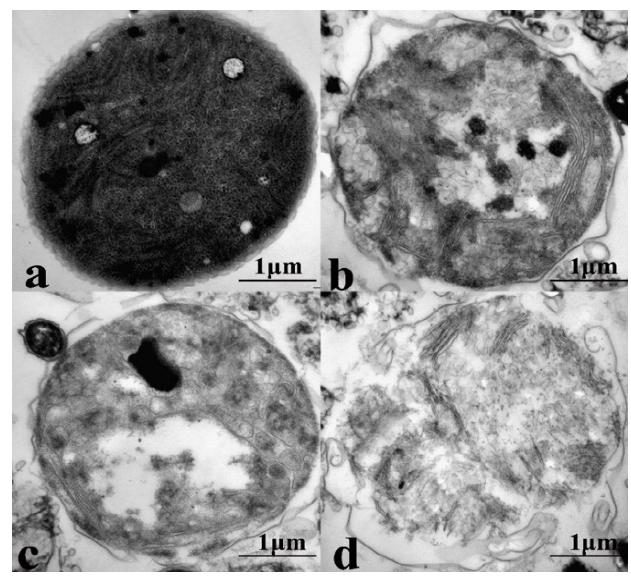
Figure 11. The structural changes of 39 # bacteria to Microcystis aeruginosa under scanning electron microscope. ( a) : Normal algae. ( b – d ) : Changes after 1, 2, 3 days of inoculation of 39 # bacterial solution, respectively.